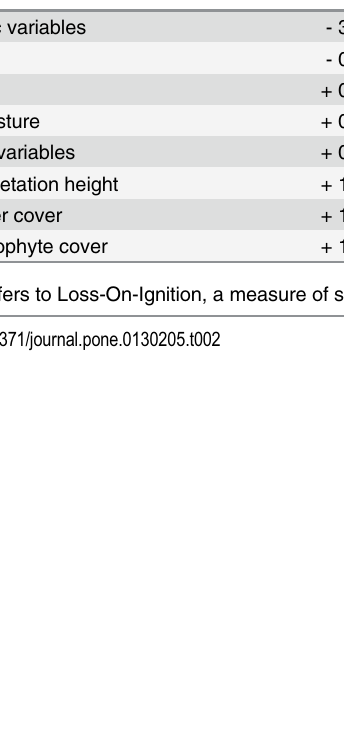
Table 3. ANOVA estimates, F- and P-values of the relative proportion of the explained variation accounted for by biotic (vs abiotic) variables in re- dundancy analyses (RDA) of graminoid and forb species composition in grassland sites along temperature and precipitation gradients in south- ern Norway.